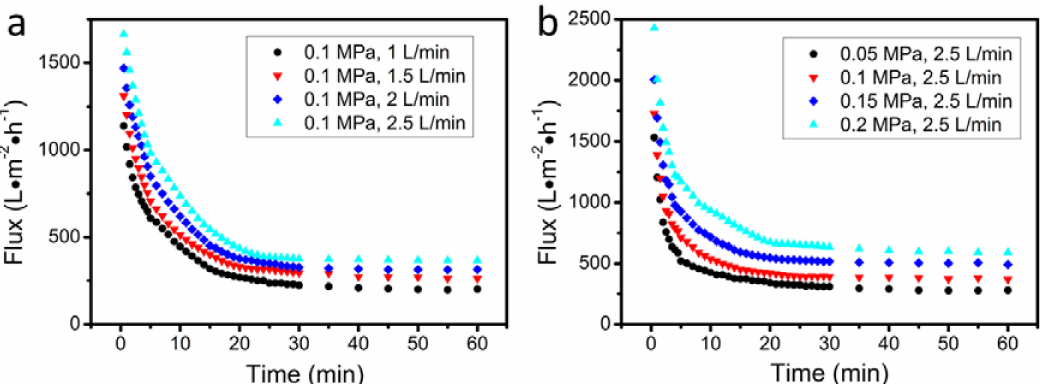
Figure 9. Permeation flux over filtration time for the produced membranes at various ( a ) flow velocities and ( b ) pressing pressures (S1350-1650 membrane, 0.1 MPa, 2.5 L/min).